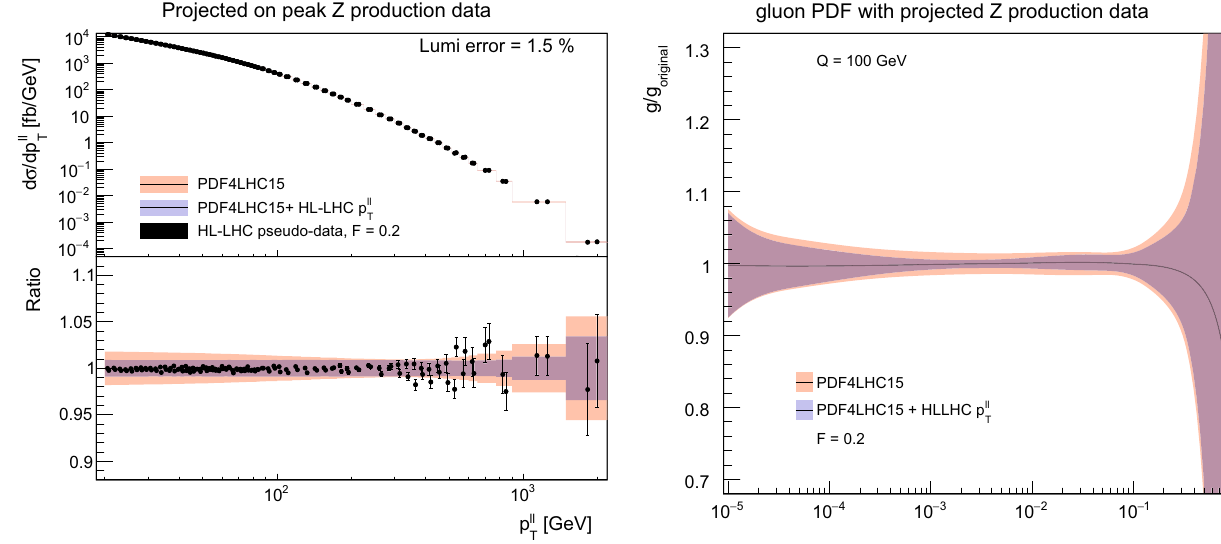
Fig. 16 Left:asinFig.5,nowforthe p T distributionof Z bosonsinthedileptonfinalstate,intheon–peakbindefinedby66GeV ≤ m ll ≤ 116GeV. Right: as in Fig. 6, now for the gluon PDF after including the HL–LHC Z transverse momentum pseudo–data in the fit Table 2 The three scenarios for the systematic uncertainties of the the reduction factor f red , Eq. (2.2), applied to the systematic errors of HL–LHC pseudo–data that we assume in the present study. These sce- the reference 8 TeV or 13 TeV measurements. We also indicate in each narios, ranging from conservative to optimistic, differ among them in case the name of the corresponding LHAPDF grid